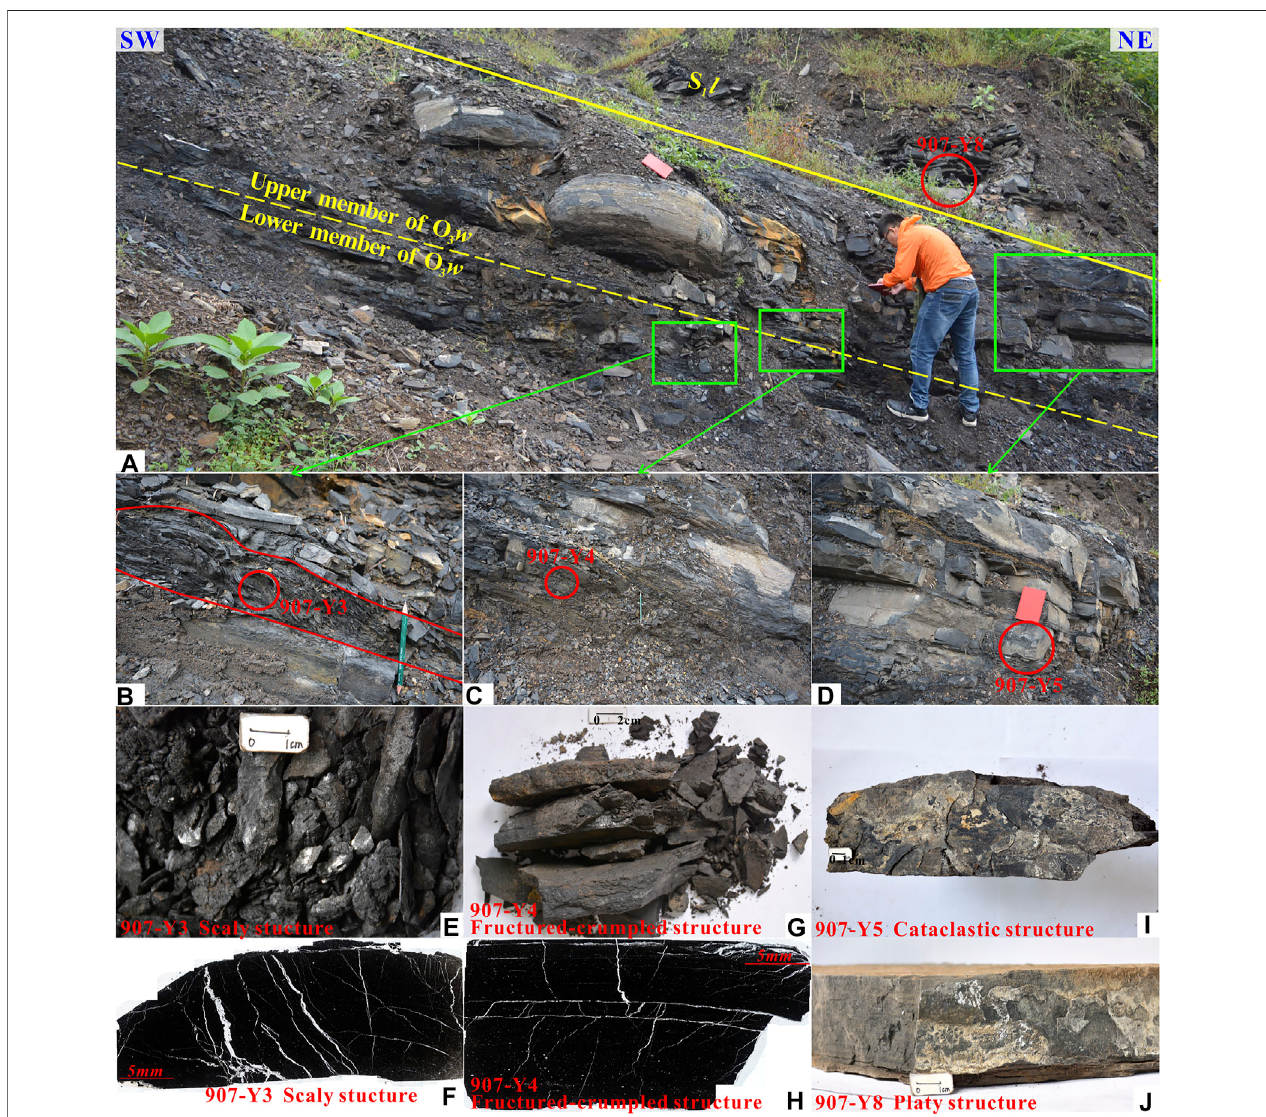
FIGURE 5 | Shale deformation characteristics of the Wufeng – Longmaxi Formation in observation point J0705. Notes: (A) a panorama of the Wufeng (O 3 w ) and Lower member of the Longmaxi Formation (S 1 l ); (B,C) the lower member of the O 3 w Formation; (D) the Upper member of the O 3 w Formation; (E-J) macro and micro deformation features of shale samples with collection locations marked in